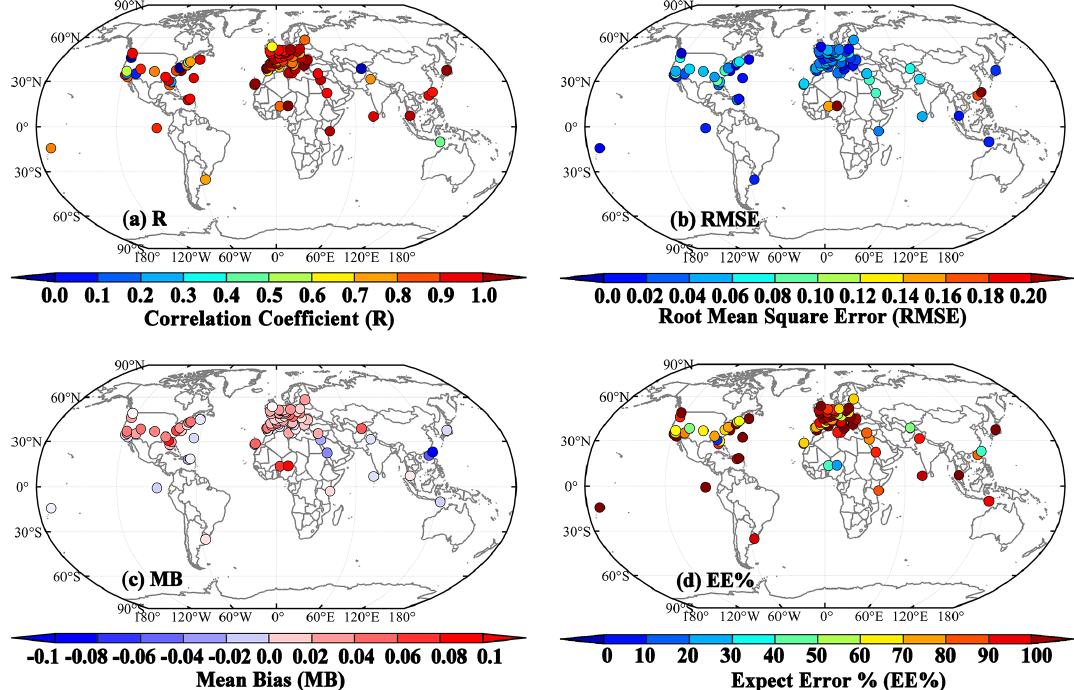
Figure 5. Spatial distributions of (a) R , (b) RMSE, (c) MB, and (d) EE% calculated from the DPC GRASP/Model scheme compared with AERONET observations. Only sites with more than five matching points are